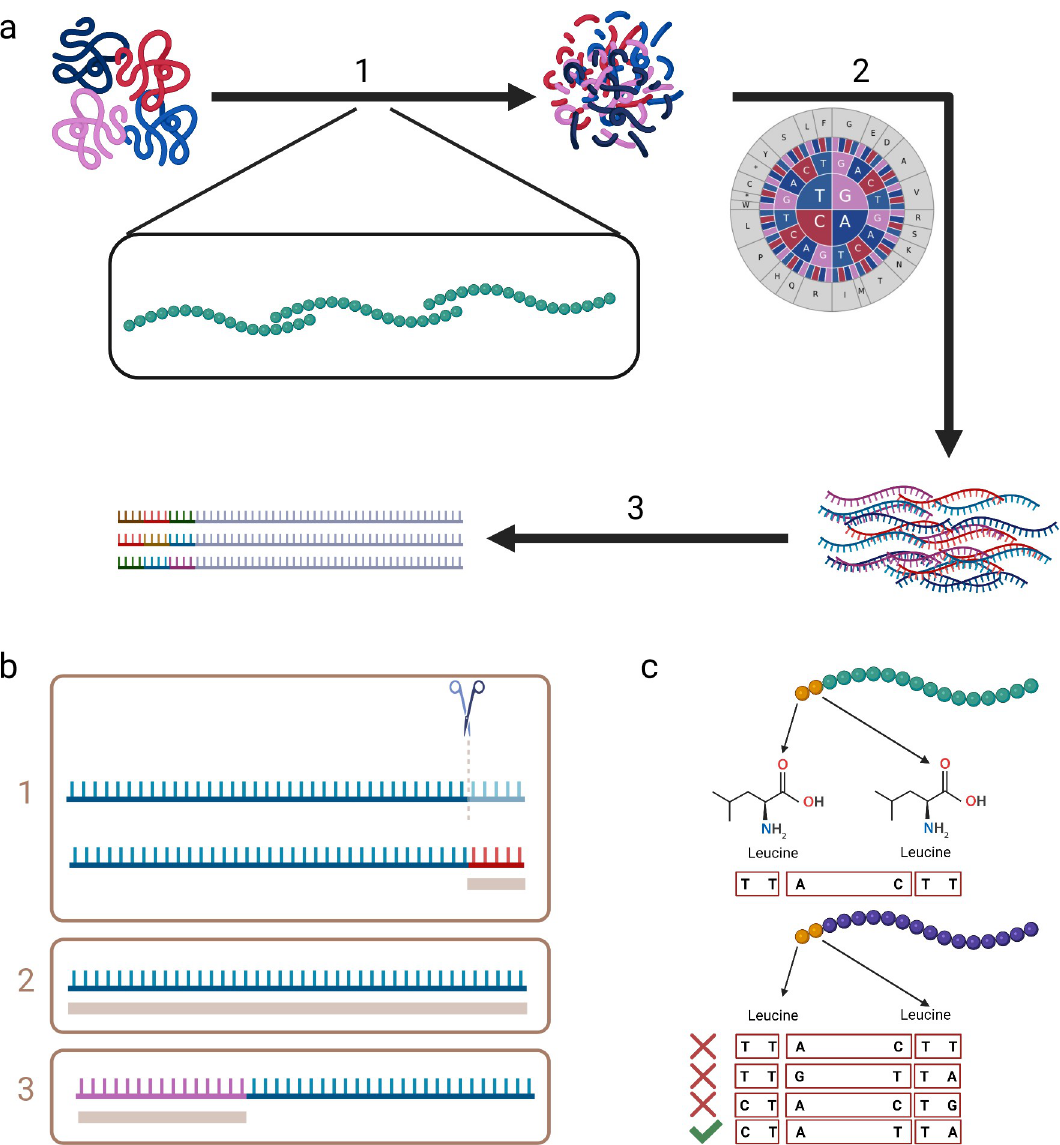
Fig 1. Library construction and barcoding schematic representation. a, Flow of inputs from peptide sequences, through software modules (arrows) including intermediate results. (1) protein sequences splitting into constant-length peptides with overlap. (2) reverse translation adhering to codon usage frequencies. (3) barcoding sequences’ tails. b, Three possible identification methodologies of oligos. In brown below are minimal sequencings required for correct identification. (1) External barcodes decrease the possible lengths of coding peptides via replacing the 3’ end with a short barcode. (2) No barcoding, requires sequencing of entire oligonucleotides. (3) Inline barcoding, requires intermediate length sequencing, and enables full-length coding peptides. c, Two possible inline barcodes of the same 5’ sequence (LL), with a hamming-distance of three and a six-nucleotide barcode (3x2 nucleotides). First oligonucleotide is barcoded without restrictions. Second oligonucleotide is restricted for three iterations, and permitted in the fourth. Figures were created with